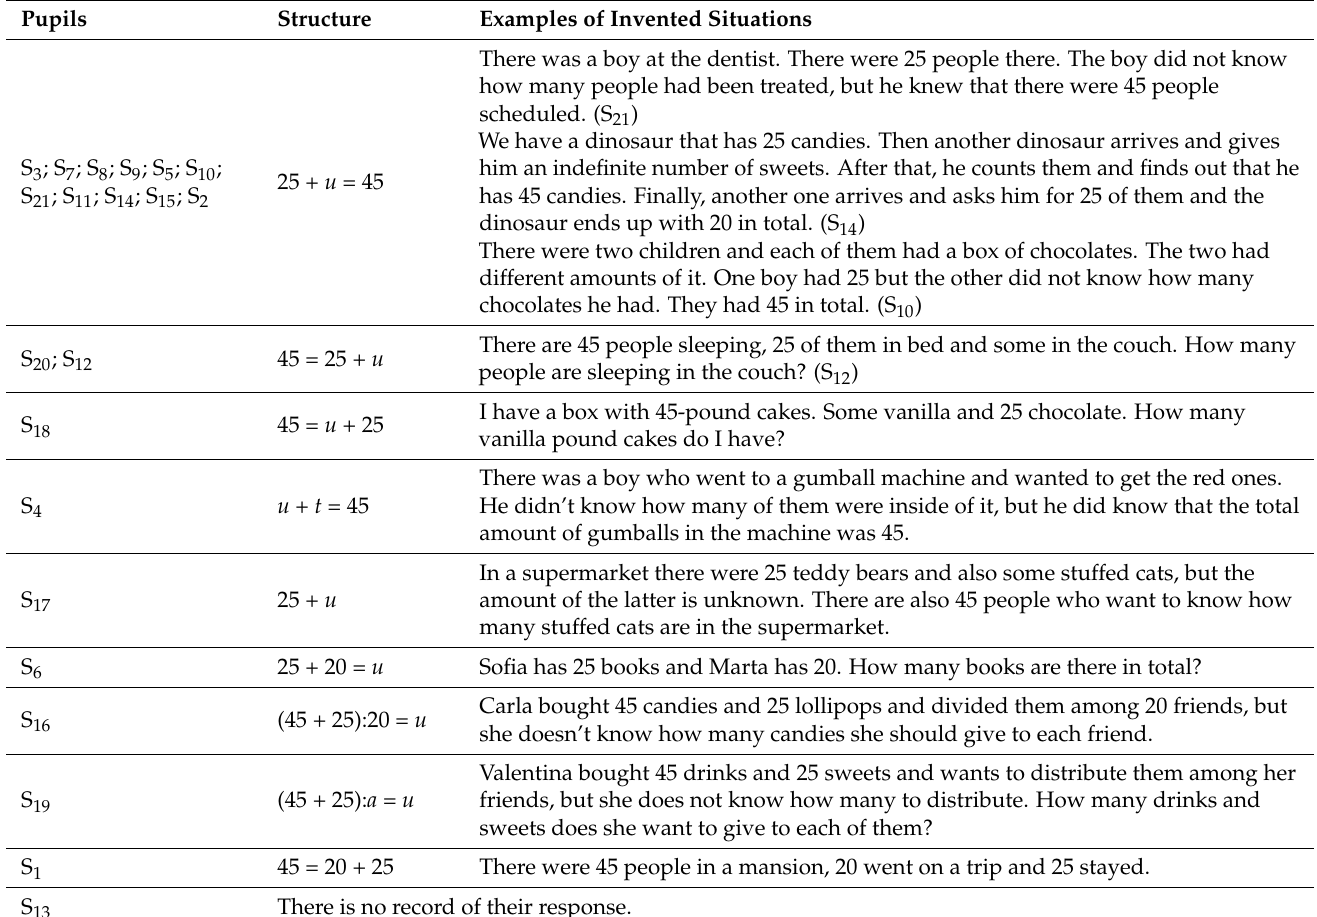
Table 3. Examples of invented situation by